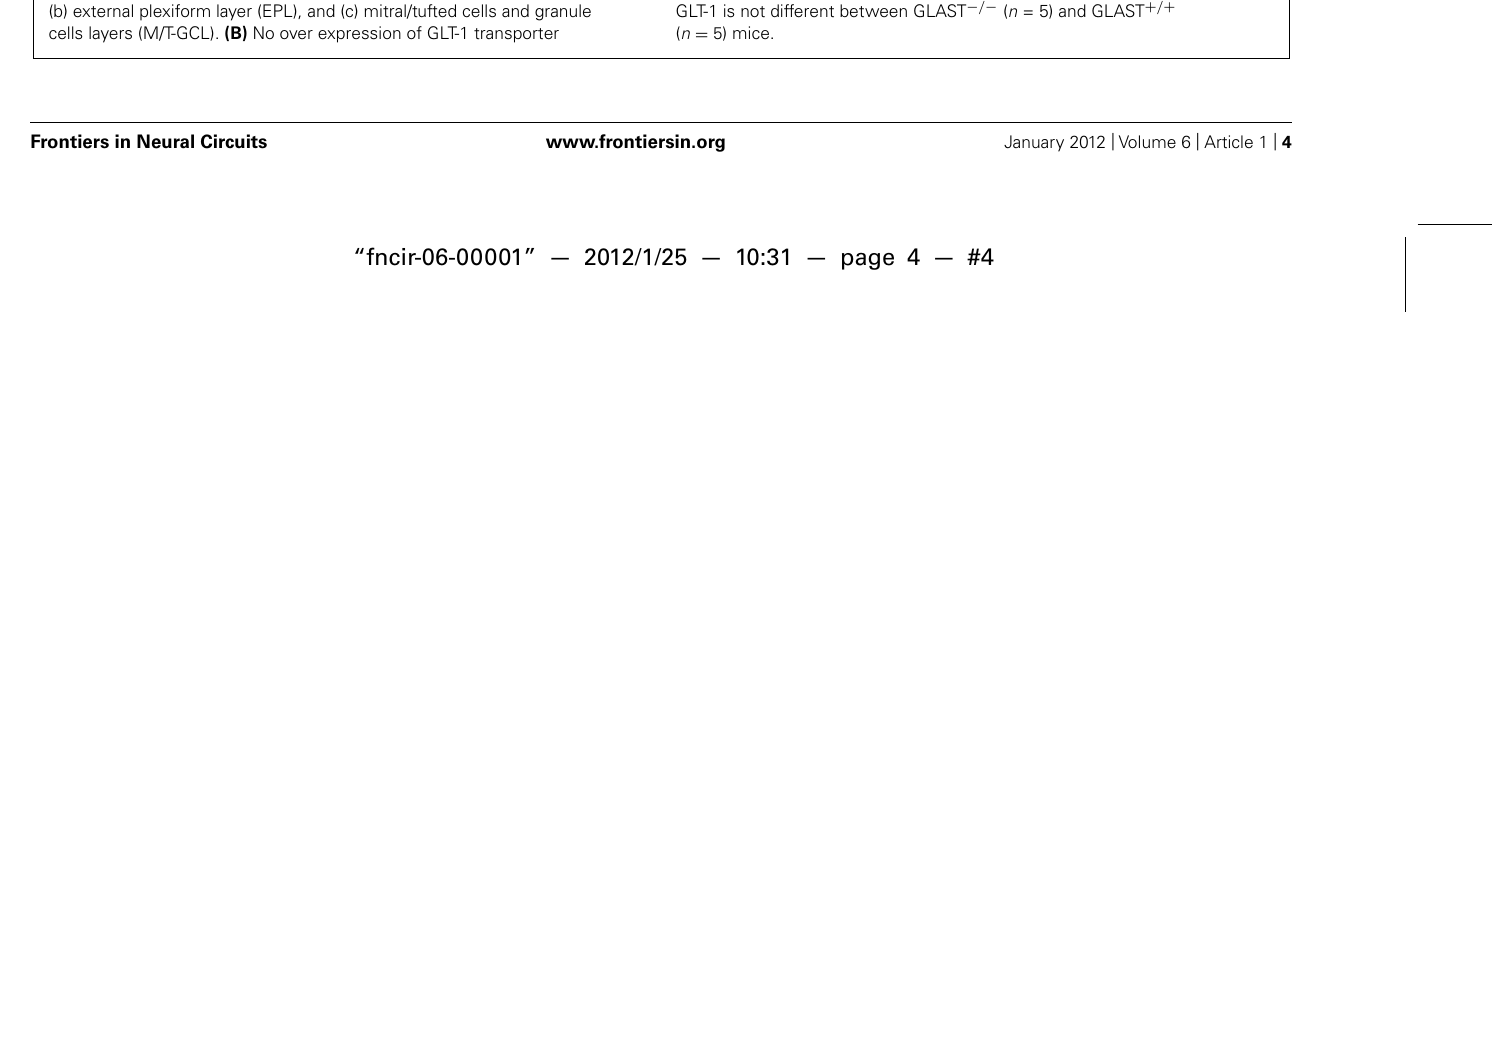
FIGURE 1 | Expression of GLAST transporter in the olfactory bulb. (A) Representative section of the adult main olfactory bulb (OB) showing immunolabeling of GLAST in (a) glomerular layer (GL), (b) external plexiform layer (EPL), and (c) mitral/tufted cells and granule cells layers (M/T-GCL). (B) No over expression of GLT-1 transporter